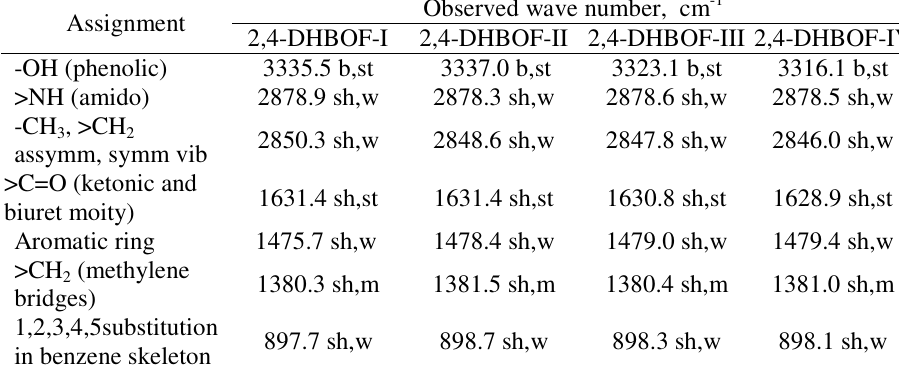
Table 3 . IR frequencies of 2, 4-DHBOF terpolymers resins.